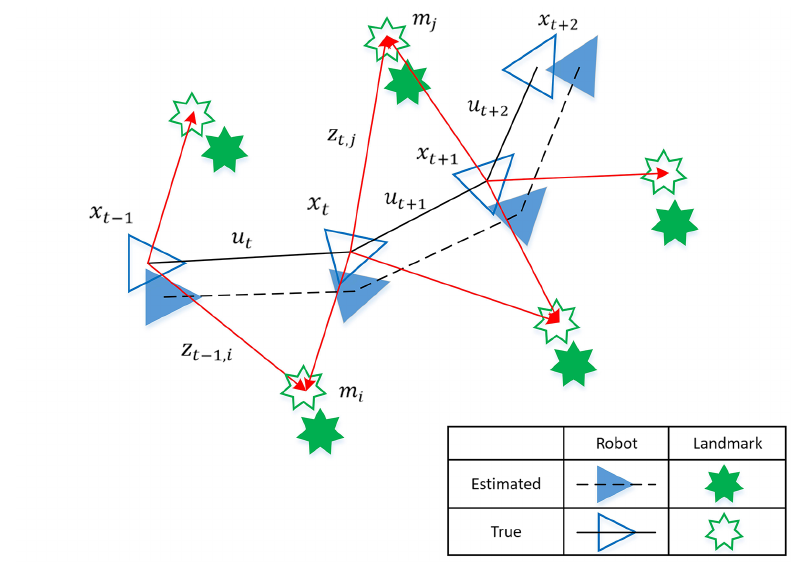
Figure 1. Schematic diagram of simultaneous localisation and mapping